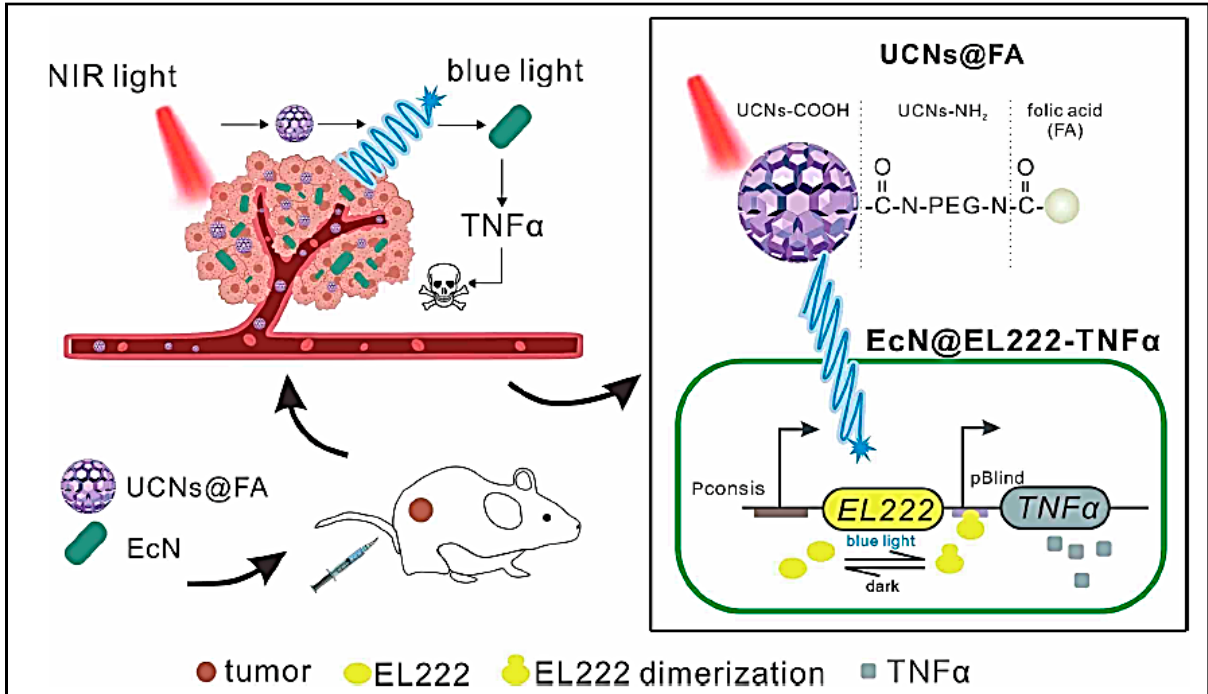
Figure 12. Scheme depicting the upconversion optogenetic system (UCNs@FA and NIR light) and engineered NIR-light-responsive bacteria (EcN@EL222-TNF) [141]. Reproduced with permissions from Huizhuo Pan et al., Chemical Engineering Journal , Elsevier, 2021.